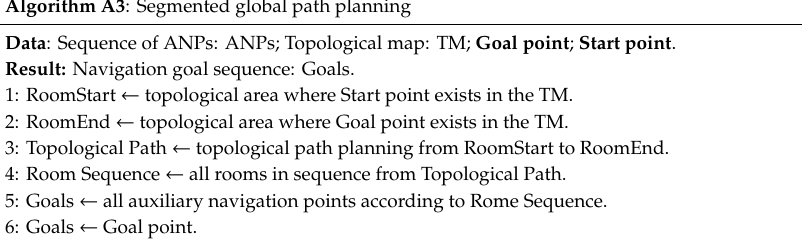
Algorithm A3 : Segmented global path